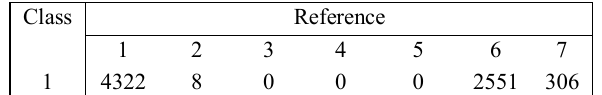
The error matrix for classification 2020 (Table 7.1 and Table classification kappa was